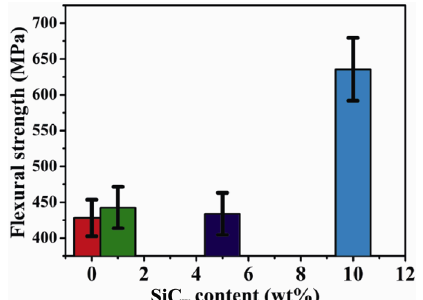
Fig. 9 SEM images of the surface after indentation test for (a, b) monolithic Ti 3 SiC 2 and (c, d) 10 wt% SiC w /Ti 3 SiC 2